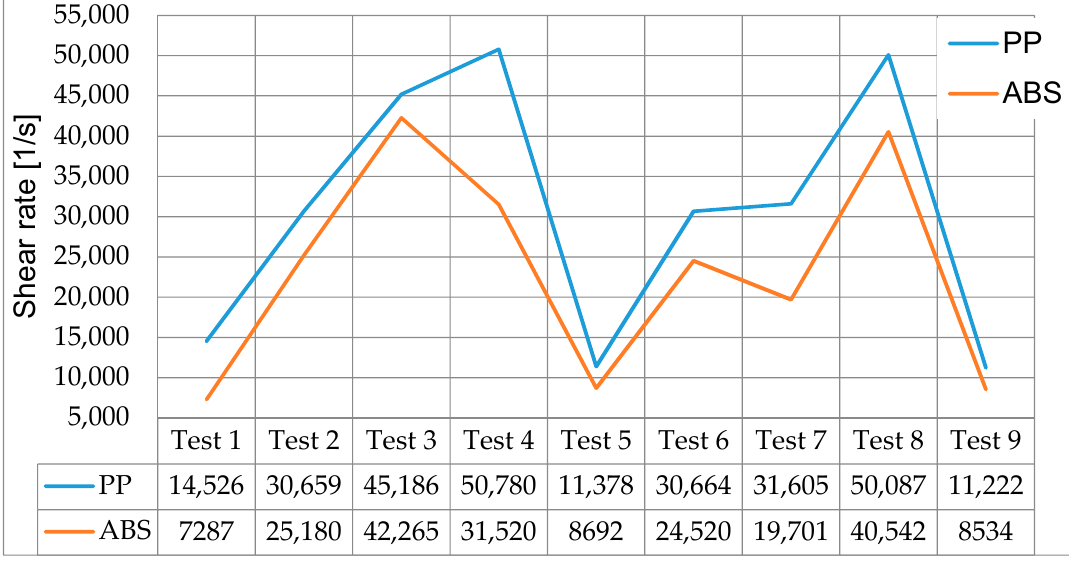
Figure 5. Maximum shear rate for PP and